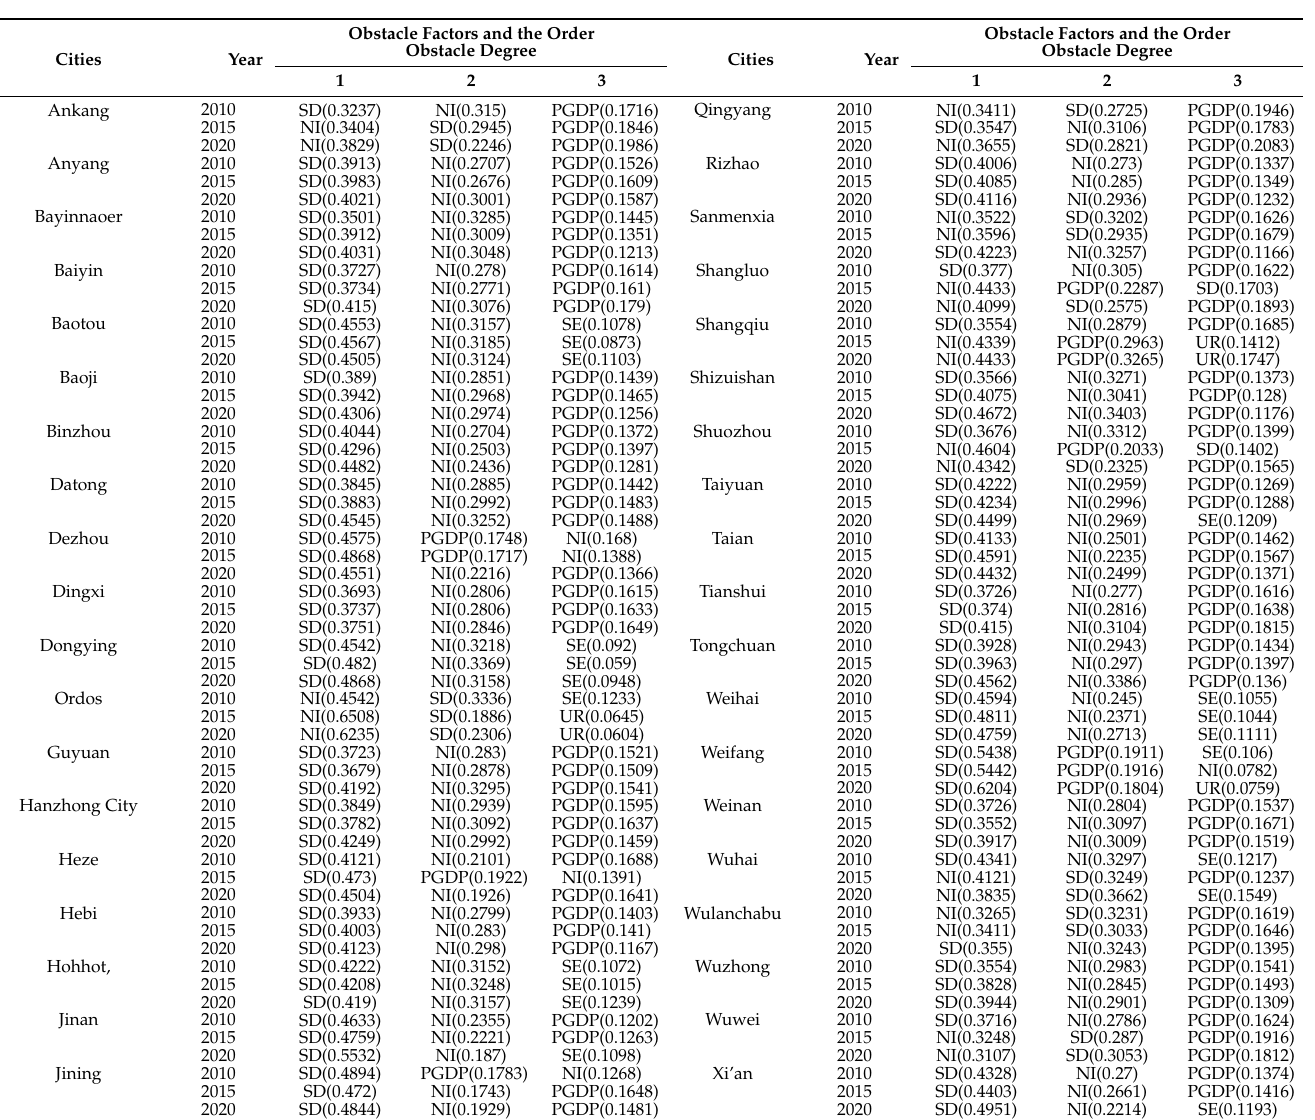
Table A1. Main obstacle elements and order of their degree of impact on the suitability of urban production in the YRB from 2010 to